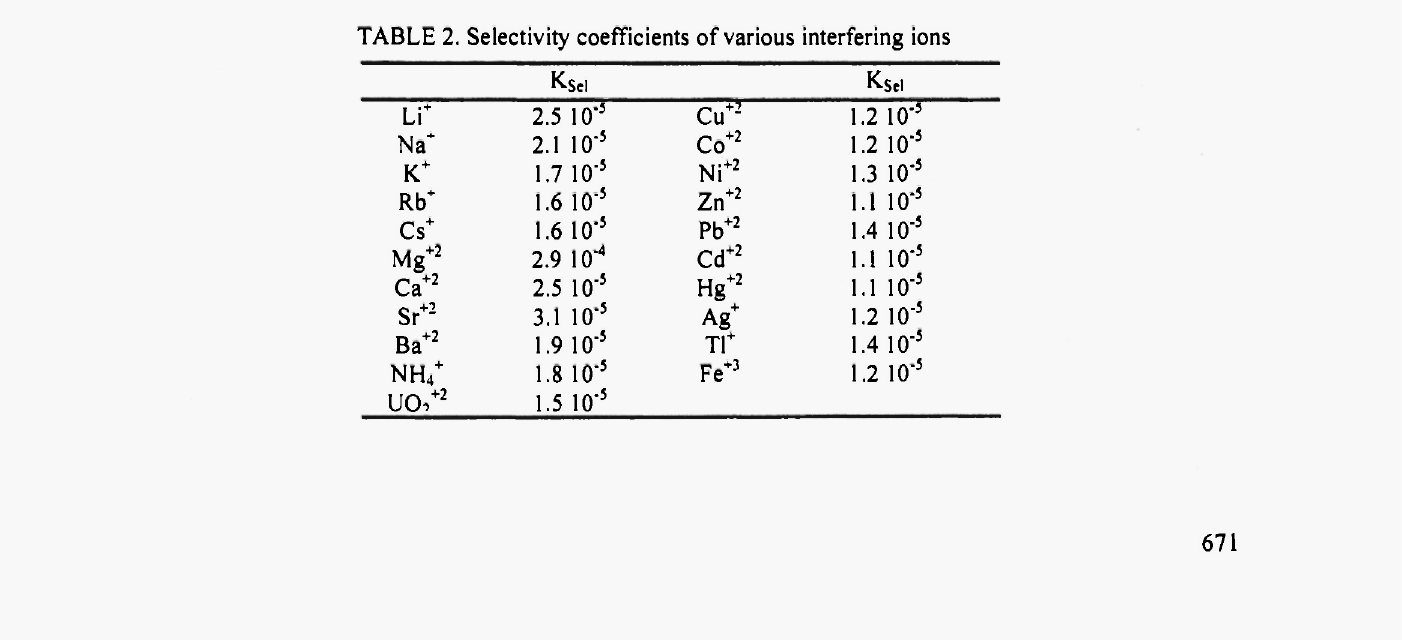
TABLE 2. Selectivity coefficients of various interfering